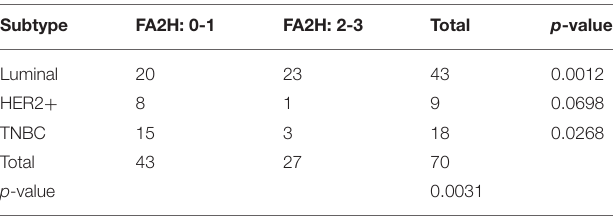
TABLE 3 | Immunohistochemistry staining results of FA2H and chi-squared test for trend in proportions.